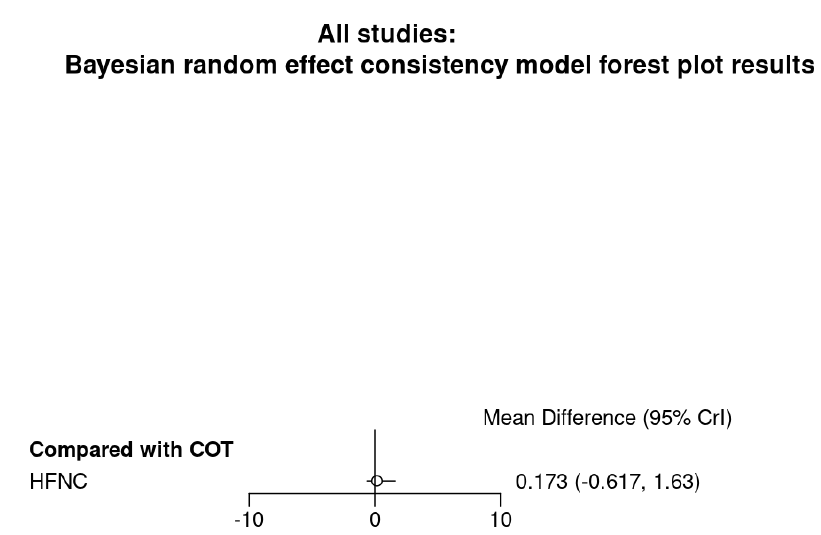
All five studies.